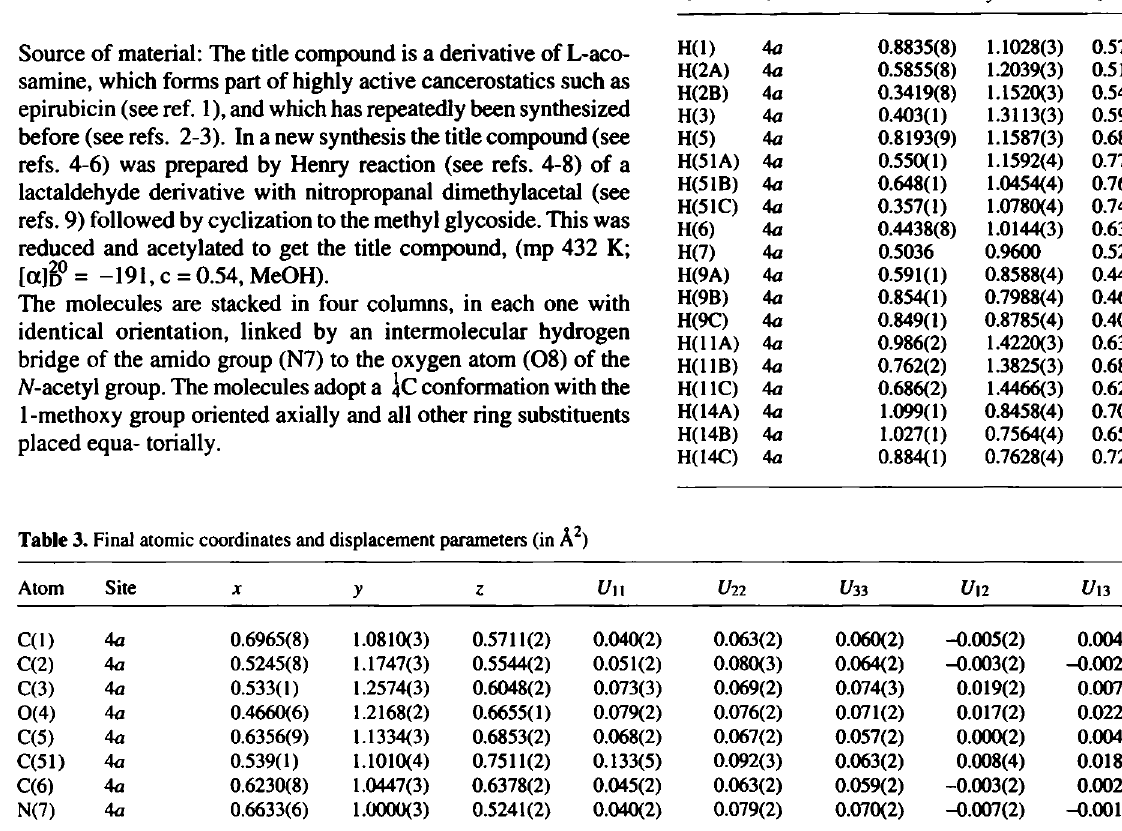
Table 2. Final atomic coordinates and displacement parameters (in